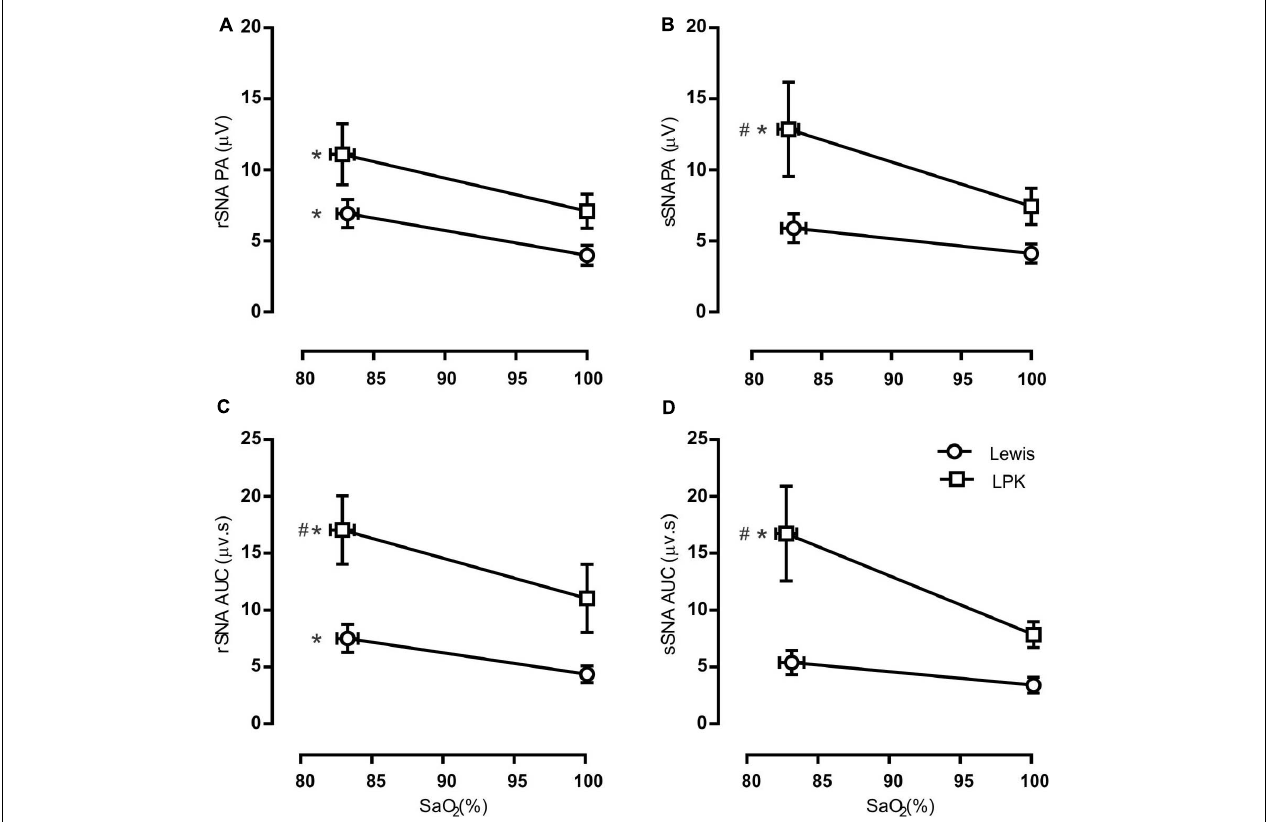
FIGURE 3 | Group data of the effect of mild hypoxia on respiratory-related sympathetic nerve activity in adult female Lewis and LPK rats. Respiratory-related sympathetic nerve activity was measured as peak amplitude (A,B) , or area under the curve (AUC; C,D ) of the phrenic triggered R rSNA (A,C) and R sSNA (B,D) during normoxia (control) and hypoxic conditions. Data are expressed as mean ± SEM n ≥ 5 per group. * P < 0.05 hypoxia versus baseline (normoxia) within each strain; # P < 0.05 LPK versus treatment-matched